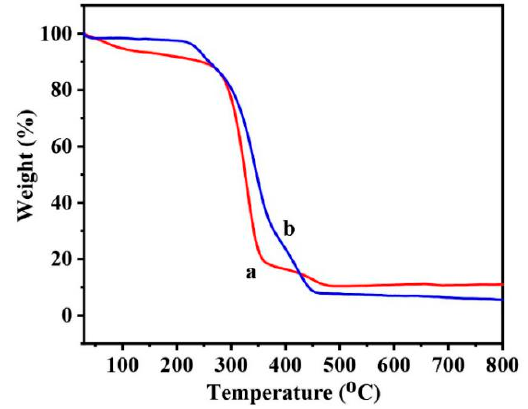
Figure 2. TGA curves of poly([V 2 C 4 (mim) 2 ]Br 2 ) (a) and poly(EGDMA) (b).